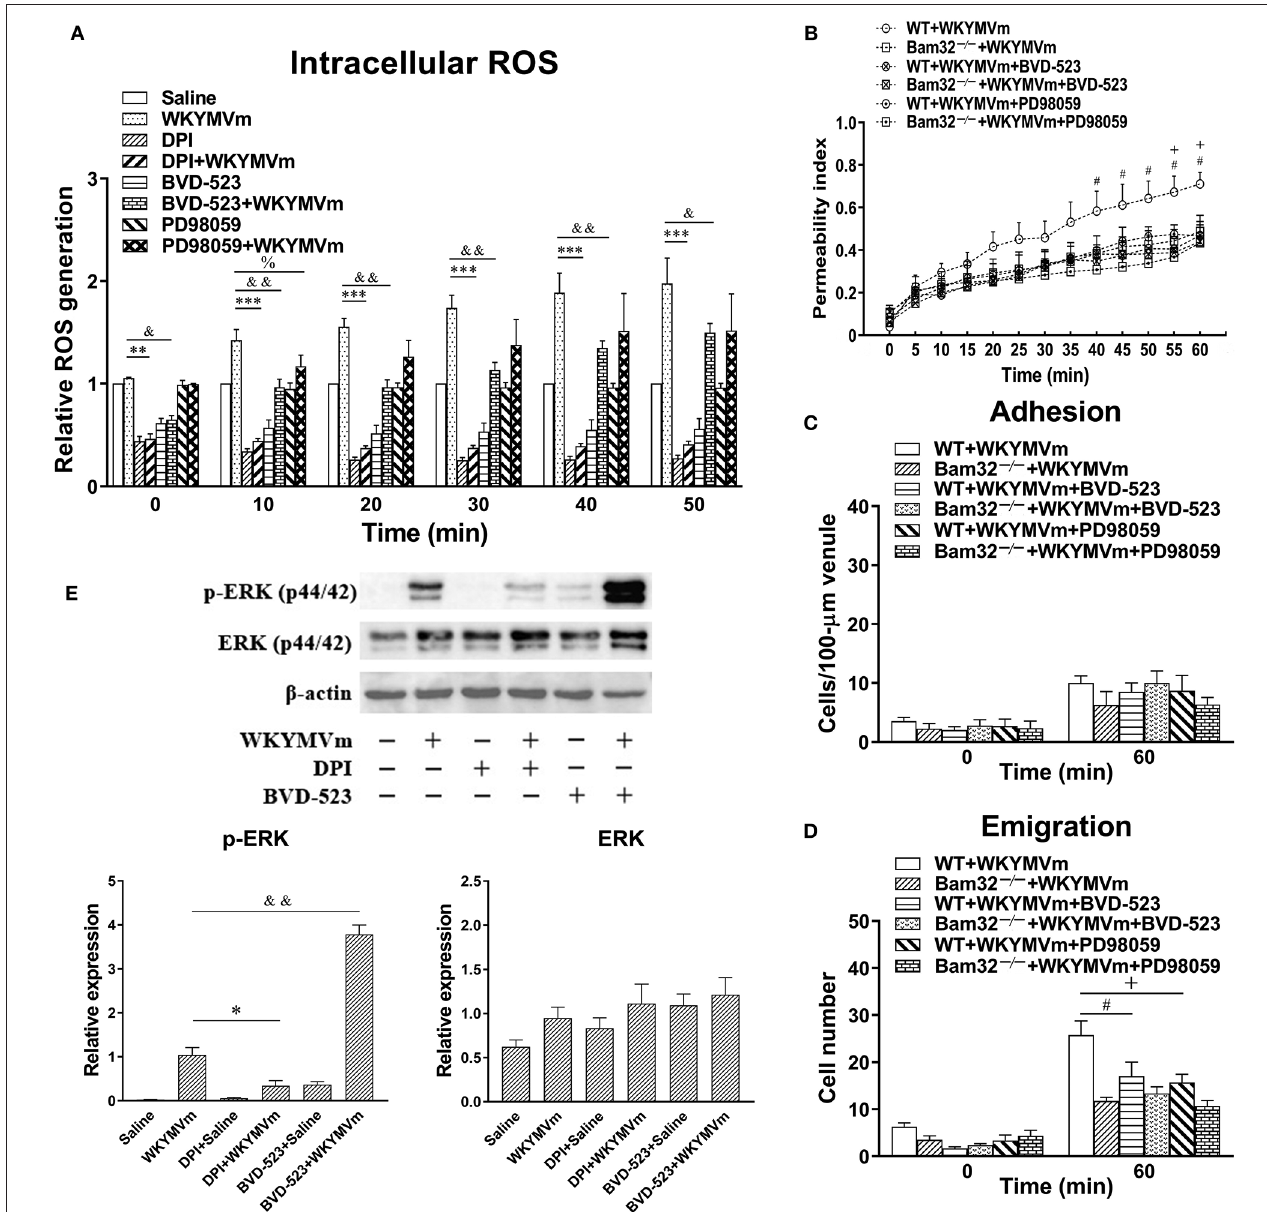
FIGURE 6 | Pharmacological inhibition of ERK1/2 signaling in WKYMVm-induced intracellular ROS generation and microvascular hyperpermeability. (A) Time course of intracellular generation of ROS in isolated neutrophils pre-incubated with vehicle (DMSO), DPI (40 µ M), BVD-523 (5 µ M), and PD98059 (50 µ M), respectively, for 30min prior to and during 60-min treatment of WT neutrophils with saline or WKYMVm (0.1 µ M). (B) Permeability indices of mouse cremasteric post-capillary venules following 60-min WKYMVm superfusion in the absence or presence of BVD-523 or PD98059 for 30min prior to and during 60-min WKYMVm superfusion in WT and Bam32 − / − mice. Neutrophil adhesion number on 100- µ m length of venule (C) and neutrophil emigration number (cells/443 × 286 µ m 2 field, D ) were determined simultaneously in the same experiments of WKYMVm-induced cremasteric microvascular hyperpermeability before (0min) and 60min following superfusion with WKYMVm in the absence or presence of BVD-523 or PD98059 in the two mouse strains. (E) Original Western blots representative of at least three independent experiments and the quantification data of phosphorylated and total ERK1/2 determined in bone marrow-derived WT neutrophils pre-incubated with vehicle, DPI or BVD-523 for 30min prior to the 2-min treatment of WT neutrophils with saline or WKYMVm. (A–E) mean ± SEM, n = 3–4. Significant differences between WKYMVm-treated WT neutrophils with and without DPI (* p < 0.05, ** p < 0.01, and *** p < 0.001). Significant differences between WKYMVm-treated WT neutrophils with and without BVD-523 ( & p < 0.05 and && p < 0.01). Significant difference between WKYMVm-treated WT neutrophils with and without PD98059 ( % p < 0.05). Significant differences between WKYMVm-treated WT mice with and without BVD-523 ( # p < 0.05). Significant differences between WKYMVm-treated WT mice with and without PD98059 ( + p <